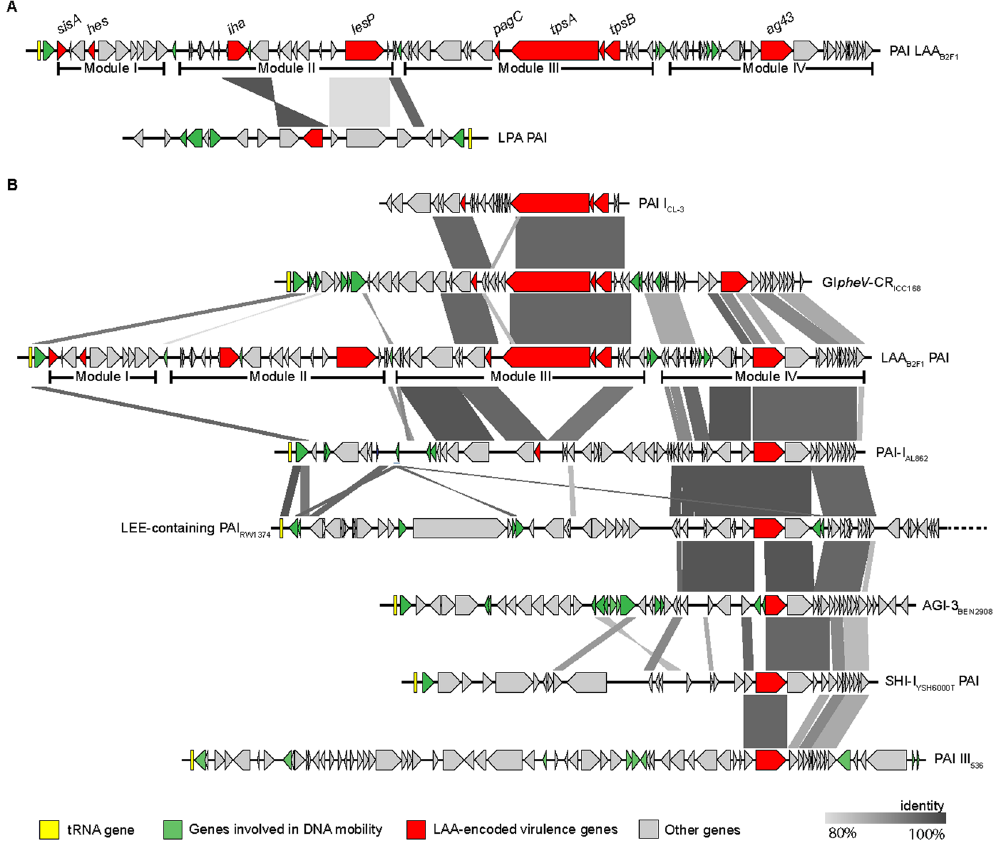
Figure 4. Comparison of the genetic structure of LAA B2F1 and related pathogenicity islands. Predicted genes and the direction of transcription are represented as block arrows. Open reading fames (ORFs) are color coded according to the legend at the bottom. The names of LAA-encoded virulence genes are indicated in the upper panel. Conserved regions are shaded in grey and the intensity of the color indicates nucleotide identity levels, from 80 to 100%. ( A ) Comparison between module II of LAA and the LPA pathogenicity island (PAI) (accession number: AJ278144). ( B ) Comparison between module III and IV of LAA and the PAI-I CL3 (accession number: AY275838), GIpheV-CRICC168, PAI-I AL862 (accession number: GQ497943), LEE-containing PAI RW1374 (accession number: AJ303141; note that this PAI is only partially shown), PAI AGI-3 BEN2908 (accession number: AY857617), PAI SHI-I YSH6000T (accession number: AF200692) and PAI-III 536 (accession number: X16664). The figure was prepared using EasyFig 53